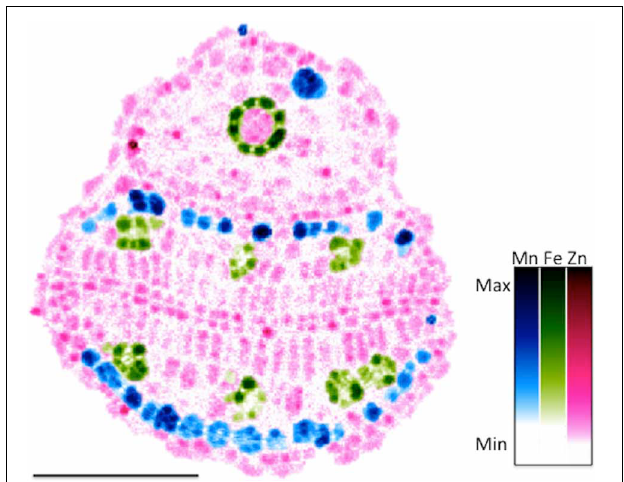
FIGURE 3 | Elemental distribution of Mn, Zn and Fe in A. thaliana seeds collected using Synchrotron X-Ray Florescence. Two dimensional map of a cross-section of an A. thaliana seed collected at 1 micron resolution at the Advanced Photon Source. Mn (blue), Zn (magenta), and Fe (green) are